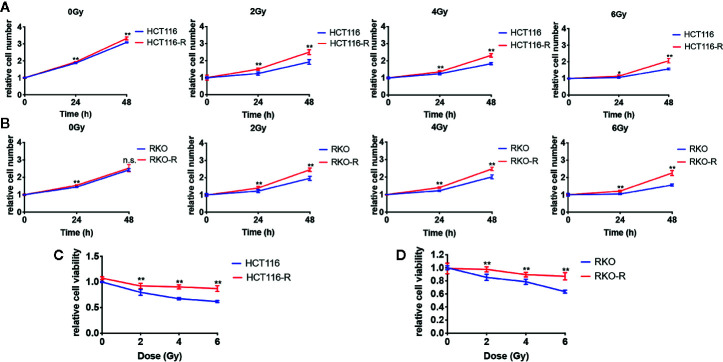
Validation of radioresistant colorectal cancer cell lines by CCK-8 assay. (A) HCT116-R cells grew faster than HCT116 cells under normal growth conditions. (A, B) When exposed to 2, 4, and 6 Gy, HCT116-R and RKO-R cells had increased proliferation rates, when compared to their parental colorectal cancer cells (HCT116 and RKO), according to the relative cell number for two incubation times (24 and 48 h). (C, D) In a dose-dependent manner, the cell growth curves of the two acquired radioresistant cells increased according to the relative cell viability, when compared to their parental cells at 48 h postirradiation. The results were shown as the mean ± SD for at least three independent experiments. *P < 0.05, **P < 0.01, n.s. means no significance.